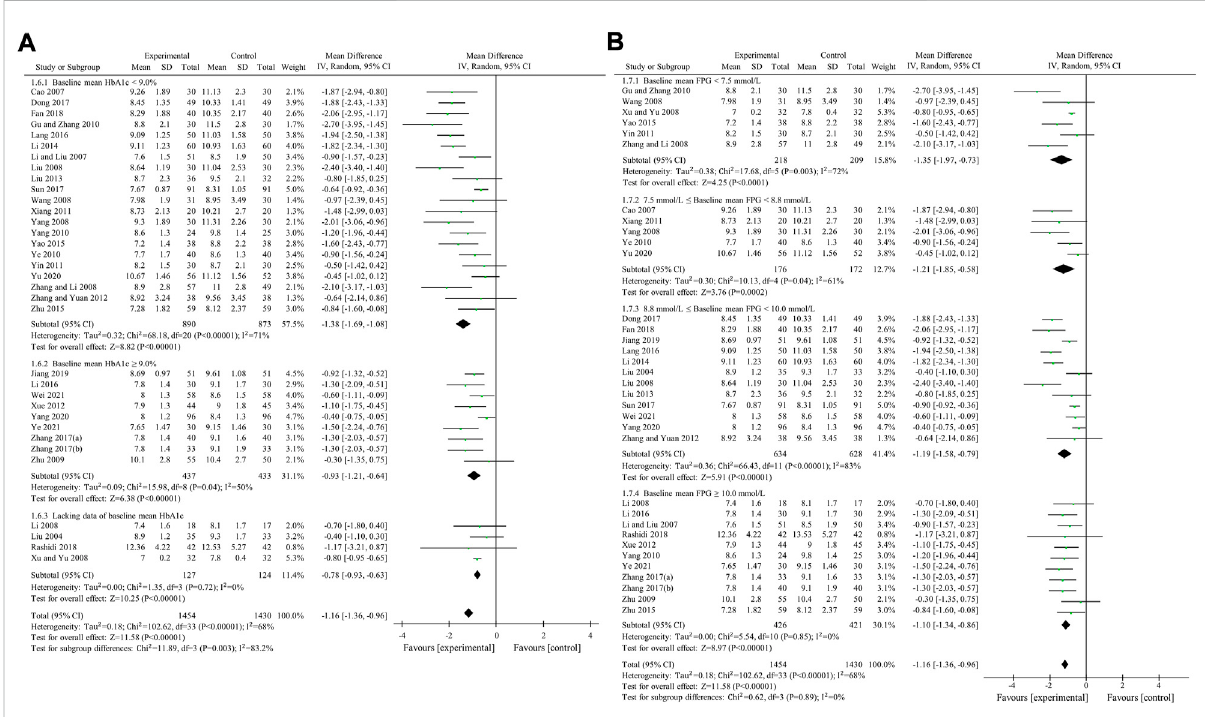
FIGURE 7 Meta-analysis of the effect of BBR on 2hPBG (A) Subgroup analysis according to baseline mean HbA1c (B) Subgroup analysis according to baseline mean